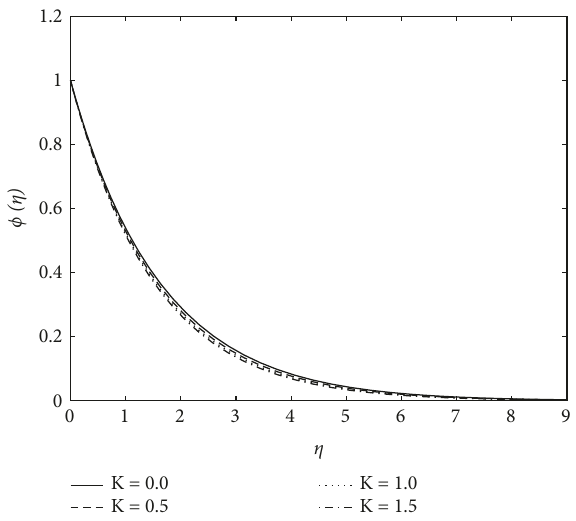
Figure 13: Change in the value of ∅ ( η ) for different values of k .